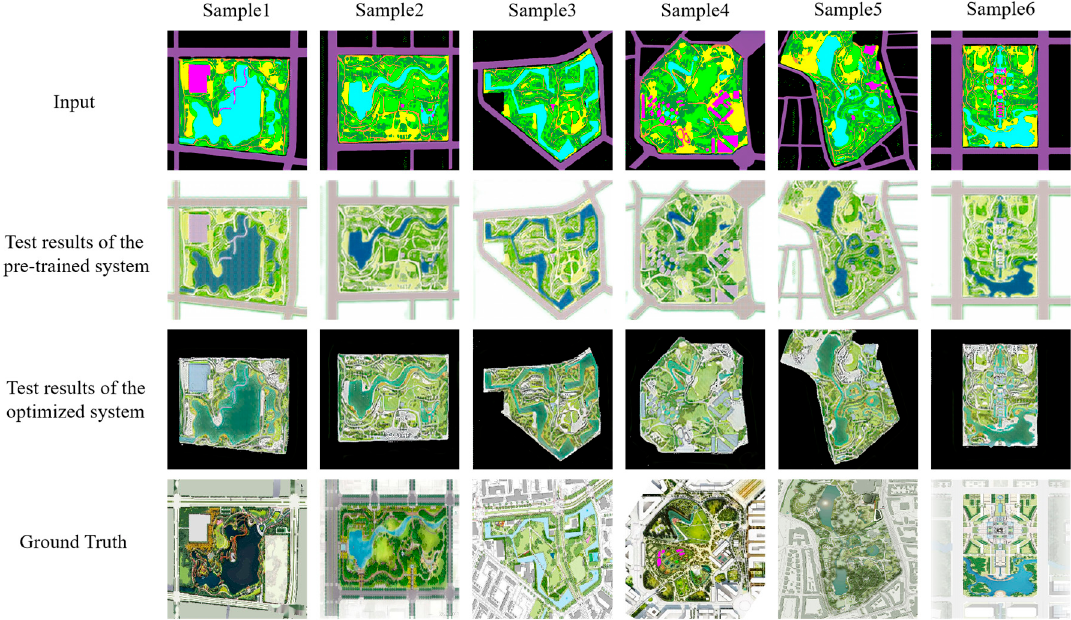
Figure 12. Comparation between test results of pre-training system and optimized system.